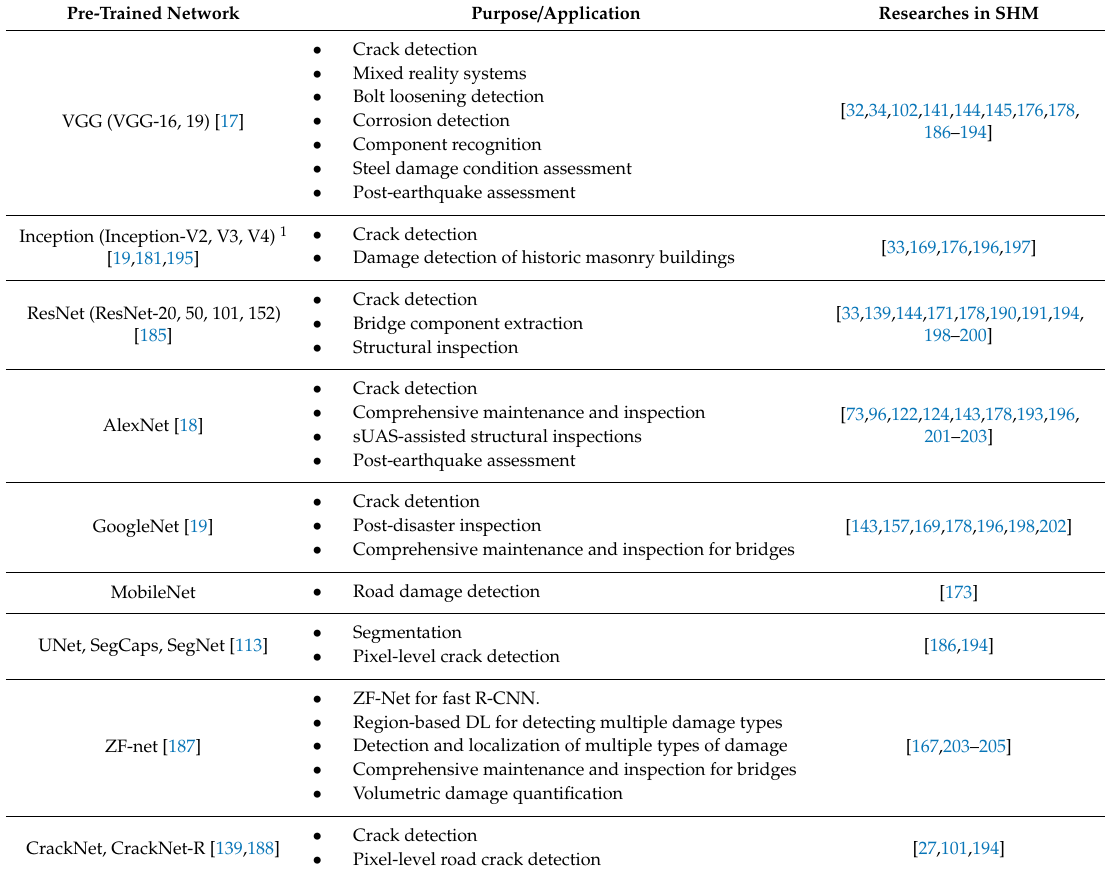
Figure 7. Four transfer learning approaches based on target domain size and similarity to the source domain [58] . Table 1. Examples of Transfer Learning (TL) Applications in SHM using pre-trained deep neural networks